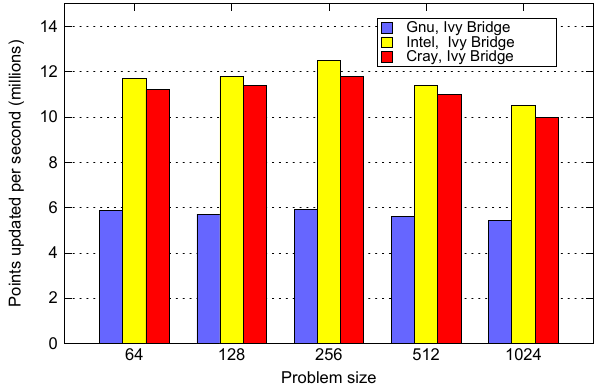
Figure 3. Summary of the best performance achieved by any PSyKAl version of NEMOLite2D for each of the compilers under